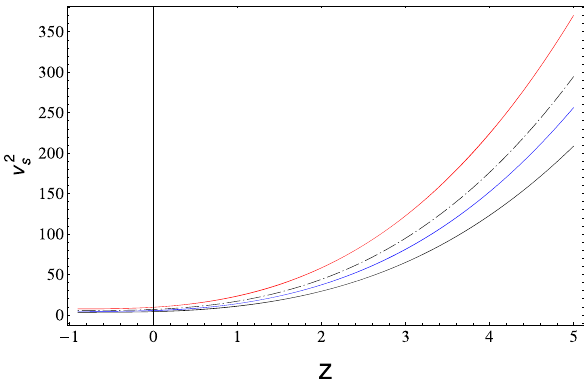
Fig. 7 Evolution of v 2 s as a function of z is shown for same values of b 2 , b 2 and (cid:5) 0 as given in Fig. 6. This plot is for δ = 2 . D 1 2